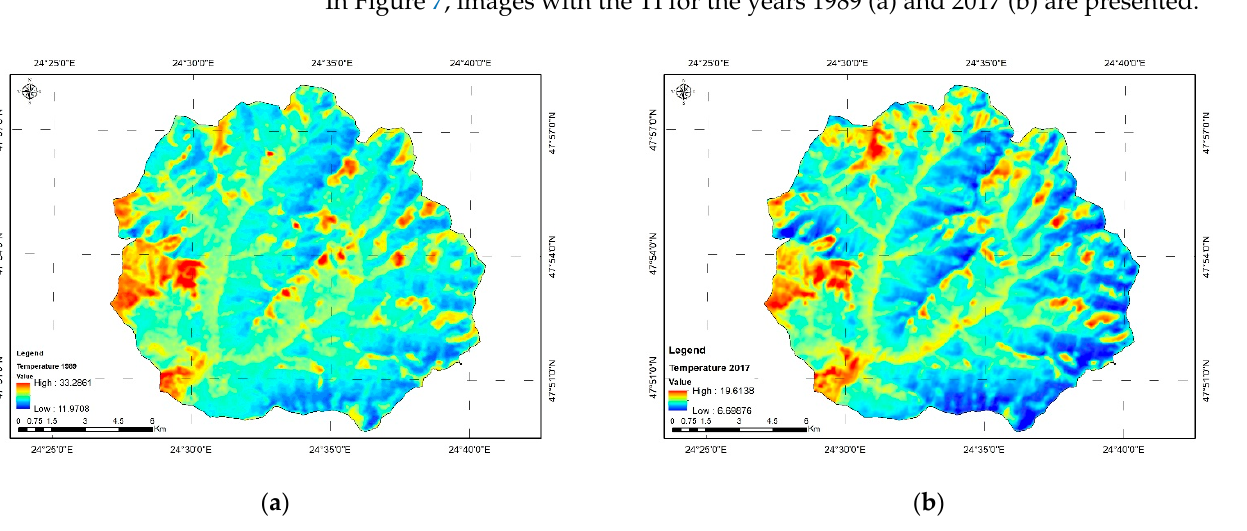
Figure 7. Thermal index (TI). ( a ) TI for year 1989; ( b ) TI for year 2017. Combining Indices to Achieve the FCD Model.